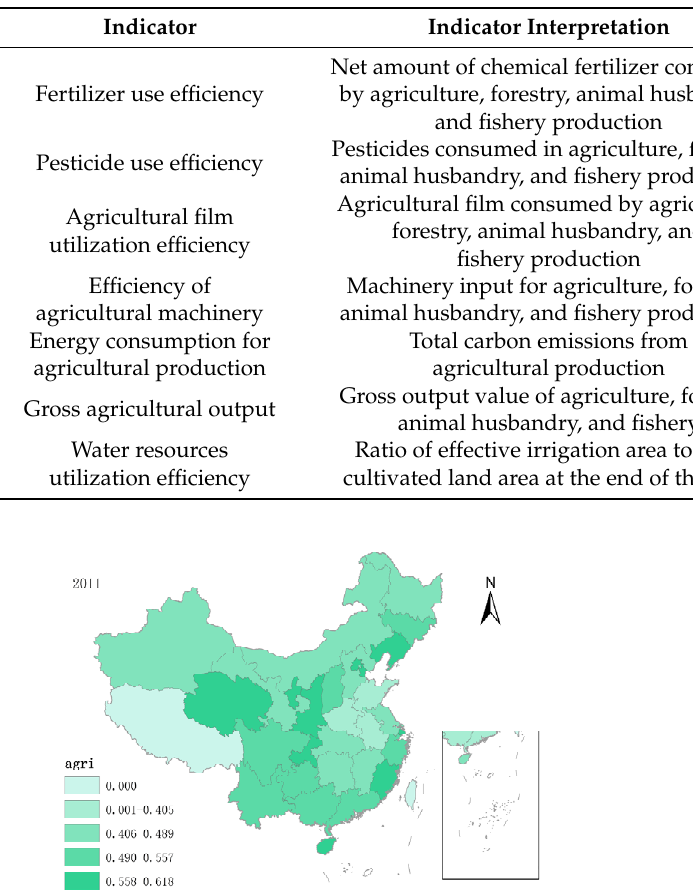
Table 2. Agricultural green development level index system.